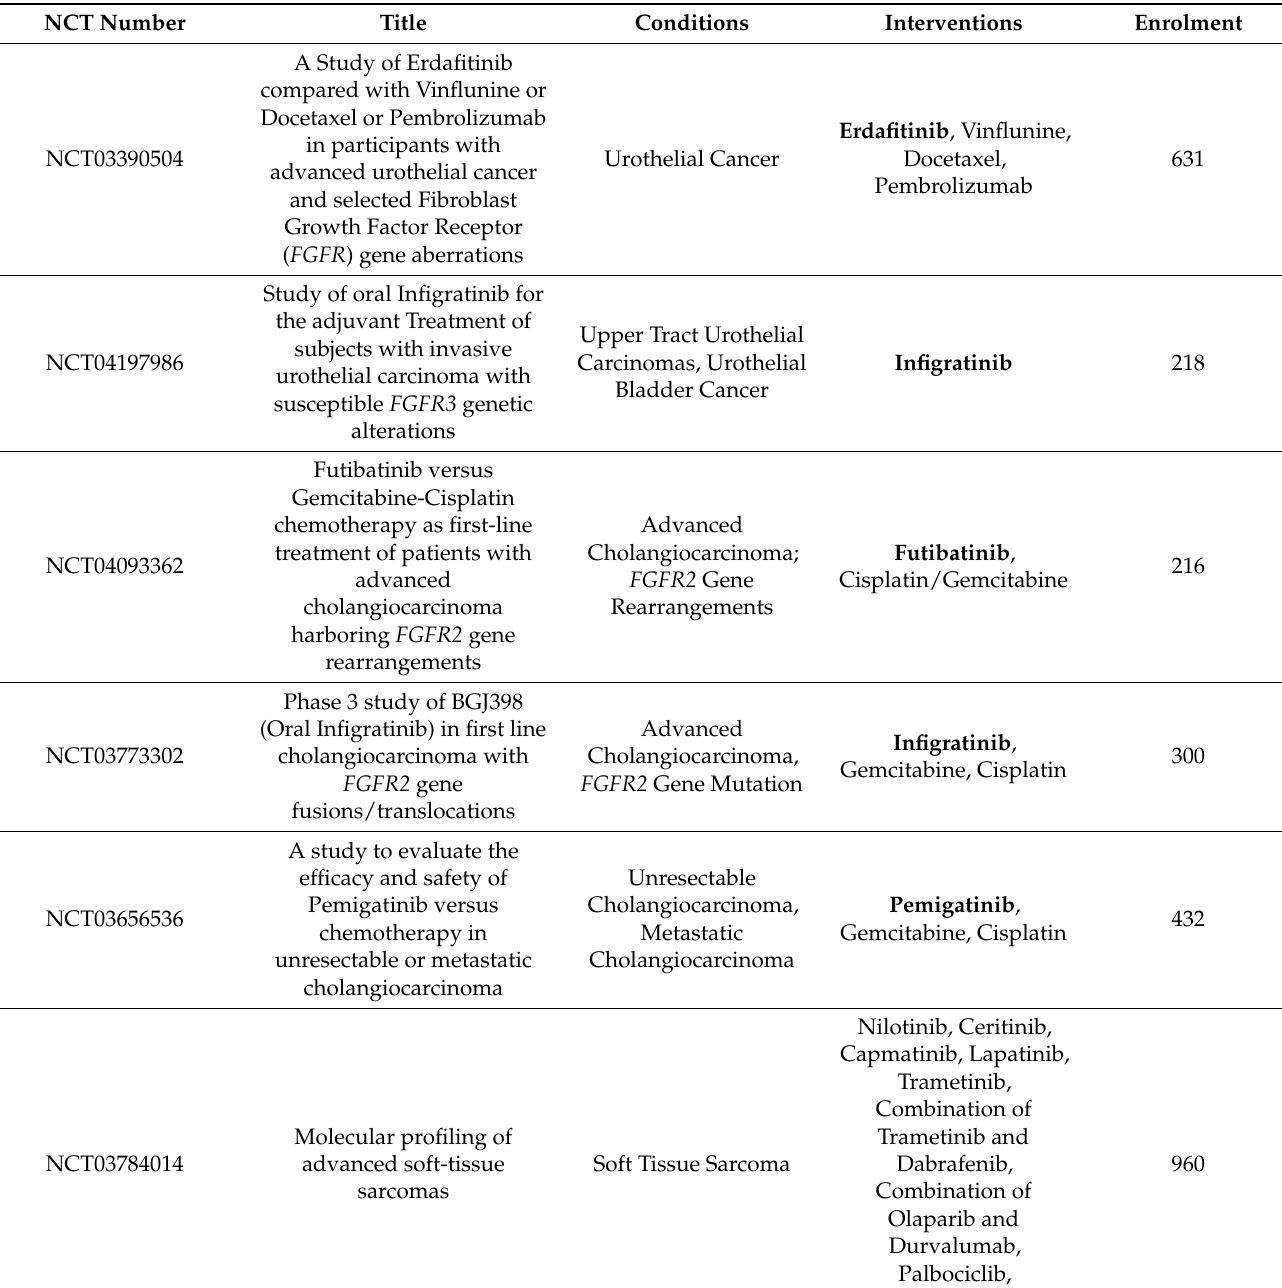
Table 1. Phase 3 Interventional clinical studies targeting FGF receptors in cancer. Currently there are no phase 4 clinical trials, however, there are over 90 phase 1 and 2 clinical trials targeting FGFR in different types of cancers, and a number of phase 3 trials not yet recruiting. FGFR inhibitors are indicated in